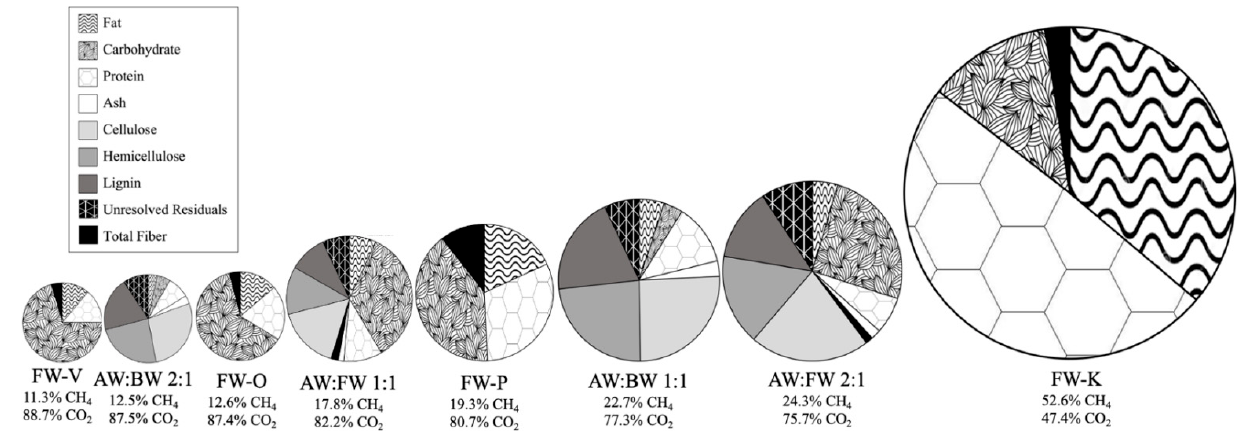
Figure 3. Biogas quality from anaerobically digested feedstock mixtures of variable compositions.